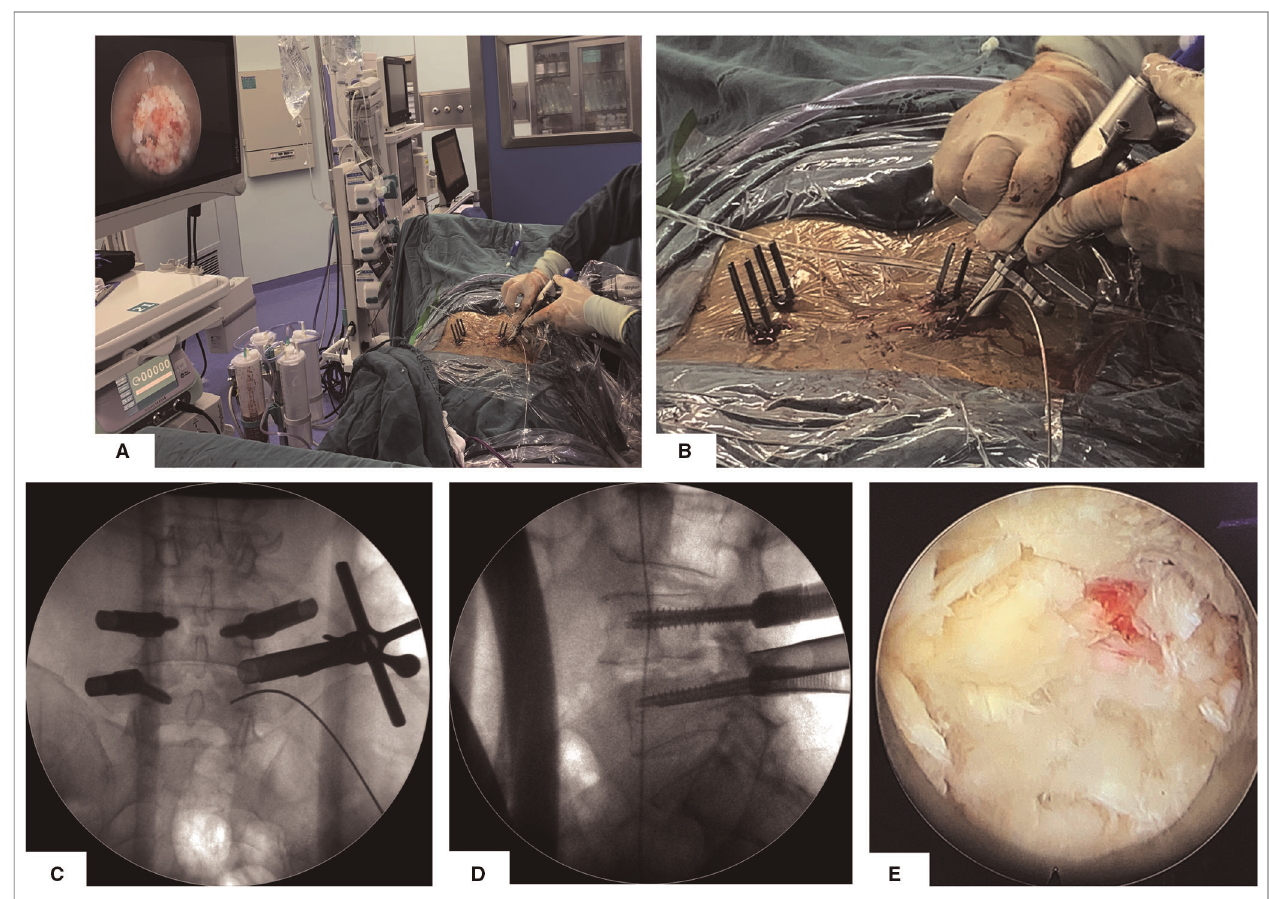
FIGURE 2 | Articular osteotomy is performed by using this visualized trephine. ( A ) General view and endoscopic visual fi eld after establishing the working channel for the visual trephine. ( B ) Detailed view when establishing the working channel for the visual trephine. ( C , D ) AP and lateral view after establishing the working channel for the visual trephine. ( E ) Endo-scopic view after articular